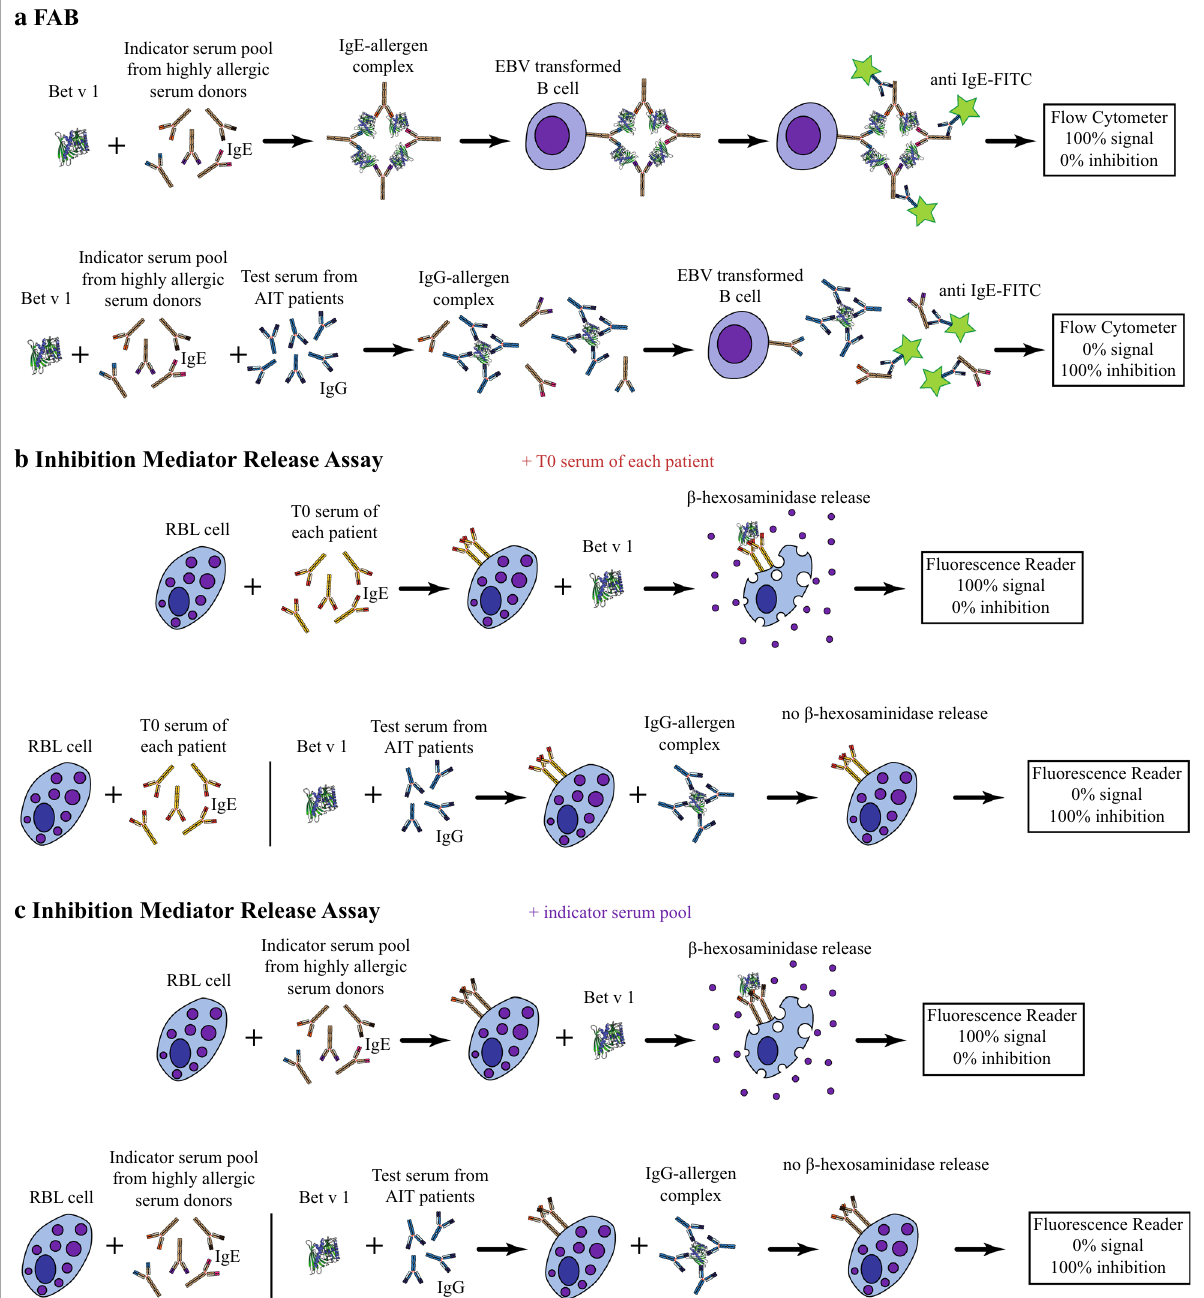
Fig. 6 Graphical illustration of assays used for measuring the AIT-induced capacity of antibodies to prevent IgE-Bet v 1 binding. FAB ( a ) and inhibition mediator release assays with T0 serum of each patient ( b ) or indicator serum pool ( c ) used as reference for therapy-induced antibodies to inhibit IgE-allergen